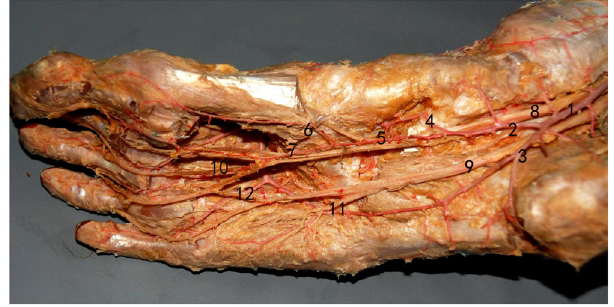
Figure 1. Bifurcation of the vascular structure and nerve (1). posterior tibial artery, (2). medial plantar artery, (3). lateral plantar artery, (4). superficial division of medial plantar artery (5). deep division of medial plantar artery, (6). Medial branch of deep division of medial plantar artery, (7). lateral branch of deep division of medial plantar artery, (8). medial plantar nerve, (9). lateral plantar nerve (10). common plantar digital nerve, (11). muscular branch to the abductor digiti quinti, (12). communicating